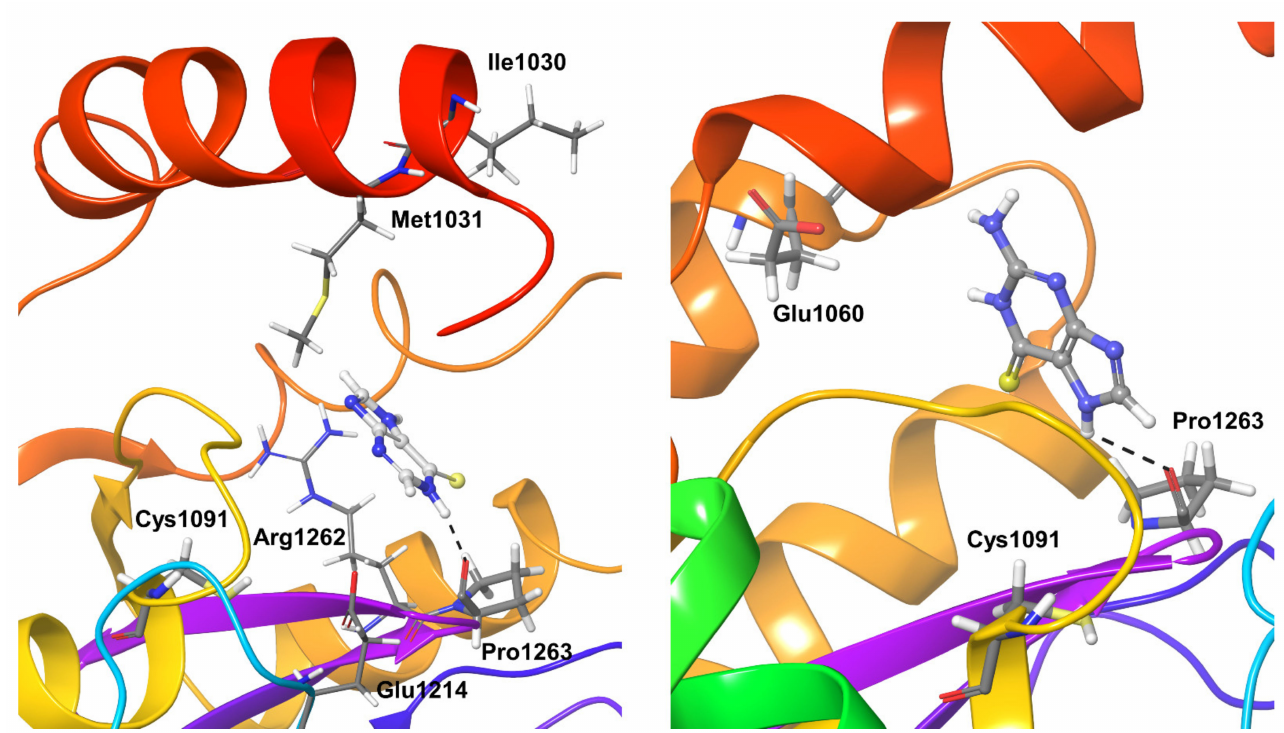
Figure 7. Stable interactions observed during MD refinement simulations of top-binding poses of Compound 1 ( left ) and 2 ( right ) with OTUB1. The inhibitors are shown in ball and stick representation, stable and moderately stable protein- ligand interactions are represented as thick tubes, and short-time interactions (for less than 30%) are represented as thin tubes.